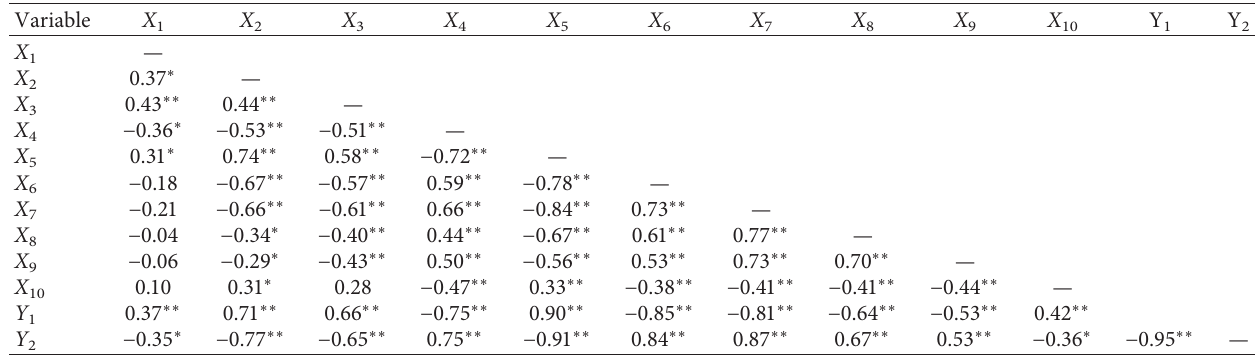
Table 4: Correlation between variables.